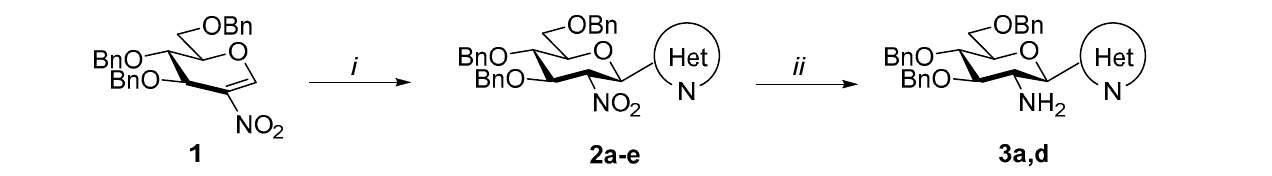
Table 1. Synthesis of C -(2 ′ -deoxy-2 ′ -nitro-3 ′ ,4 ′ ,6 ′ -tri- O -benzyl- β - D -glucopyranosyl)azines and their